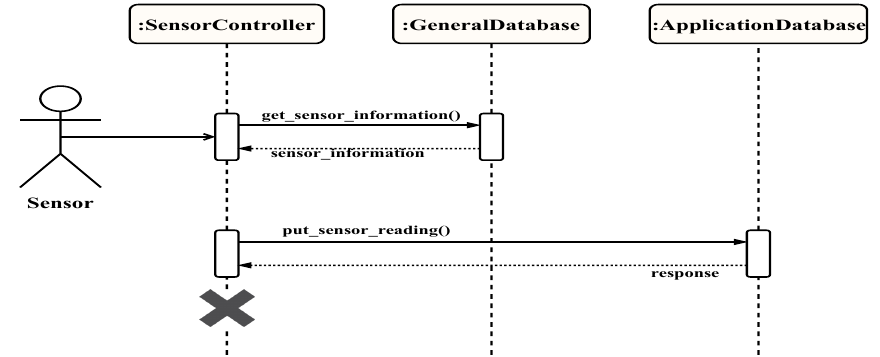
Figure 21. Input Step Database Interaction Sequence